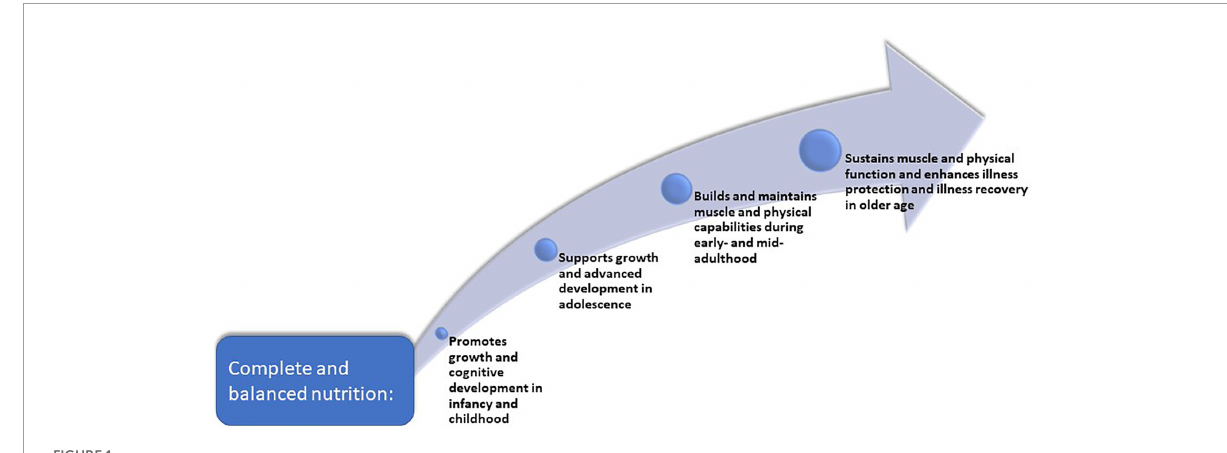
FIGURE1 Nutrition across the lifespan is foundational for health and wellbeing in older